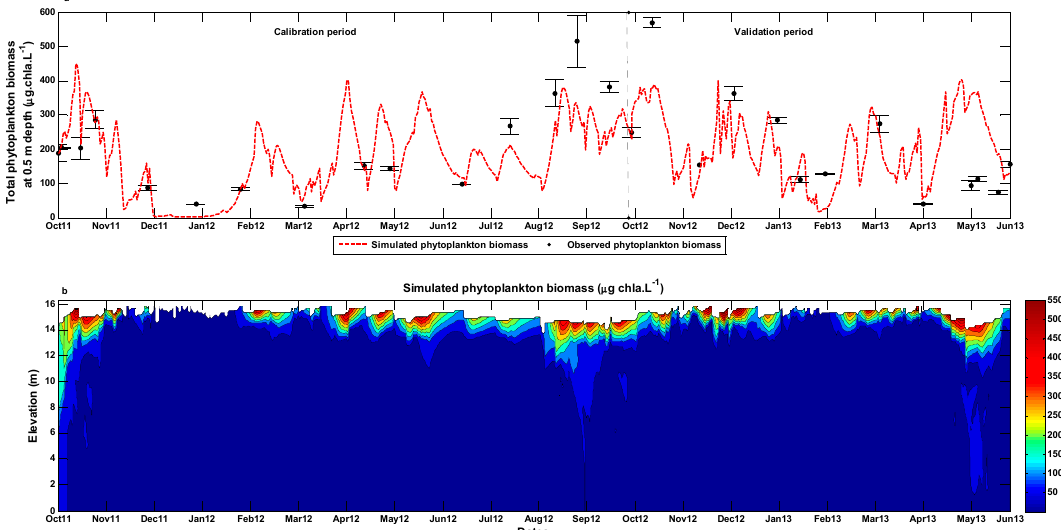
Figure 5. ( a ) Observed (dots) and simulated (dotted line) total phytoplankton biomass in Lake Pampulha at 0.50 m depth. Error bars indicate the standard deviation between samples replicates. The vertical dotted line separates the calibration an validation periods. ( b ) Simulated phytoplankton biomass in Lake Pampulha during the study period. Table 6. Model performance for phytoplankton biomass at 0.5 m depth. NMAE is the normalized mean absolute error, r is the Pearson’s correlation coe ffi cient, and n is the number of data. NMAE Calibration